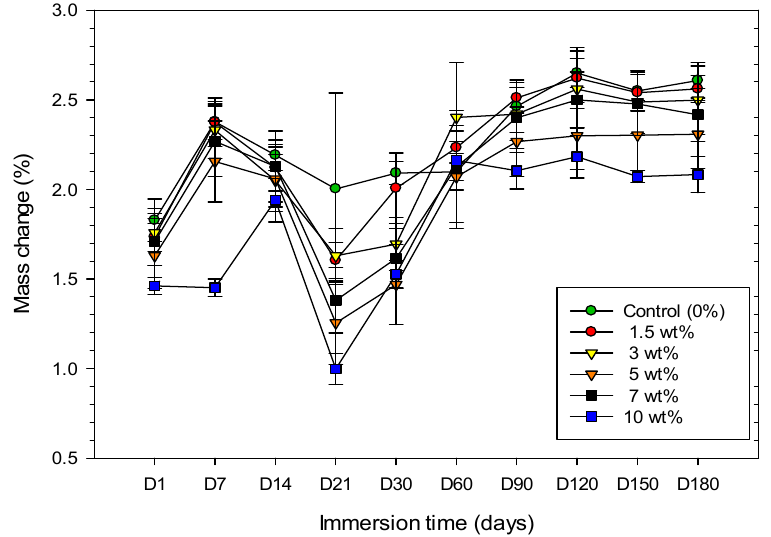
Figure 2. Line graph illustrating the mass change of specimens from six groups immersed in artificial saliva over 180 days.